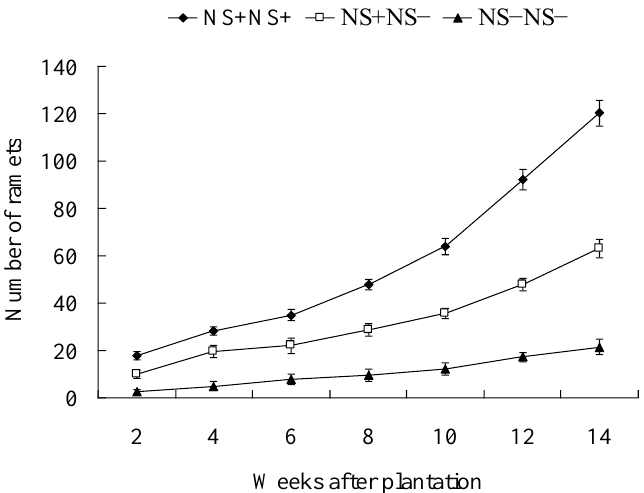
Figure 2. Time-course of clonal growth of Kentucky bluegrass under different water treatments.